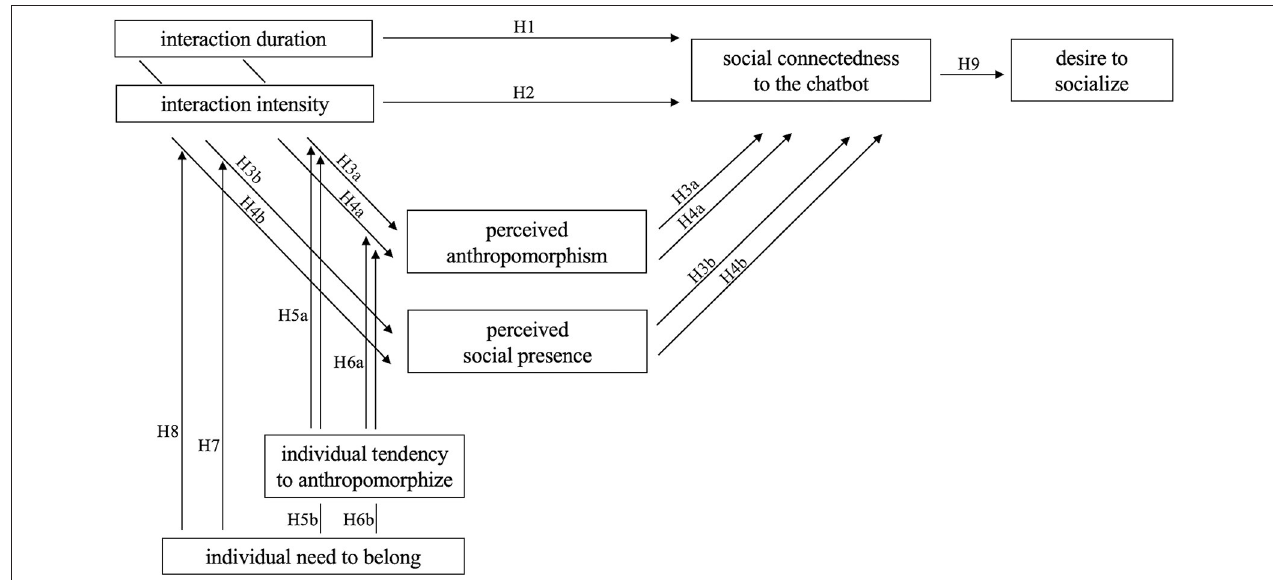
FIGURE 1 | An overview of research hypotheses.